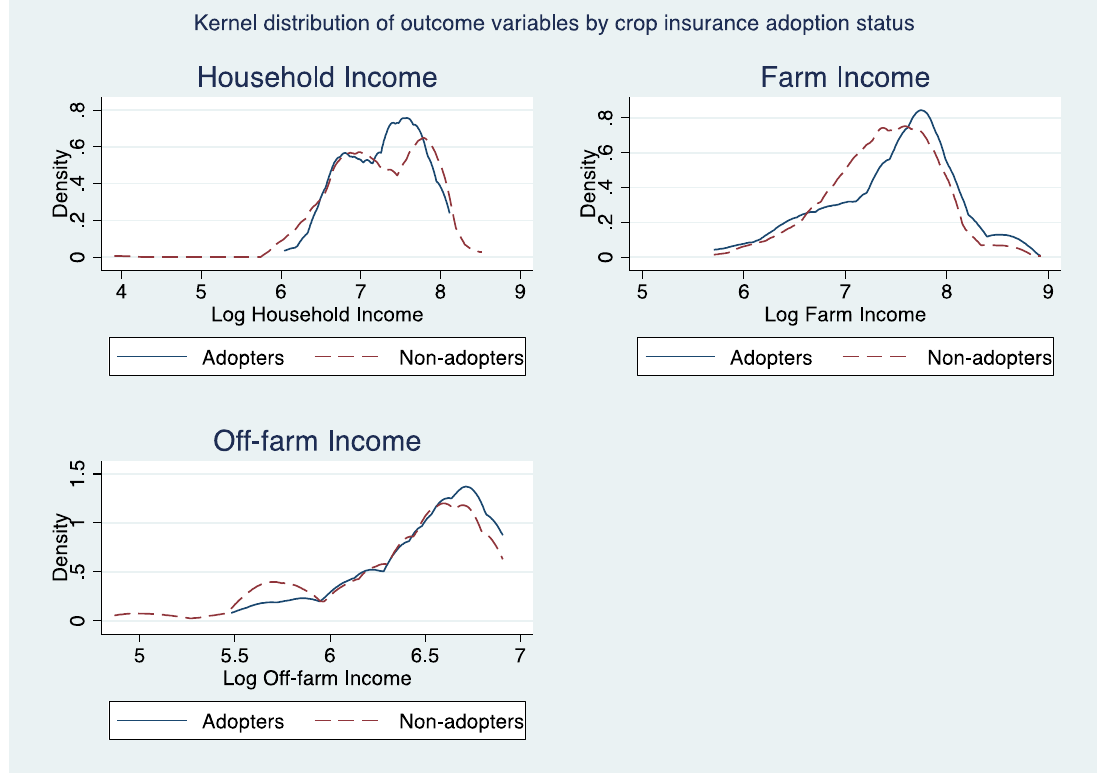
Figure 4. Kernel density distribution of outcome variables by crop insurance adoption.